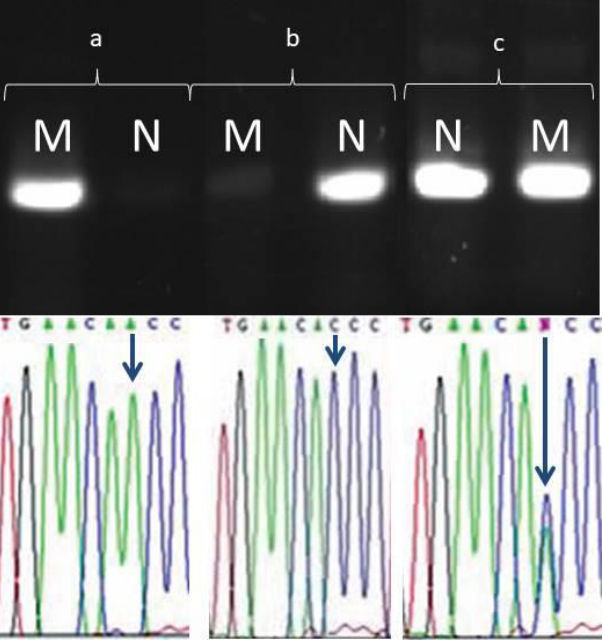
Figure 4. An example of the results from ARMS PCR in patients with His1069Gln (3207C > A) mutation: (a) a mutation in the studied allele, it is in the homozygous state; (b) wild type; (c) a mutation in the studied allele, it is in a heterozygous